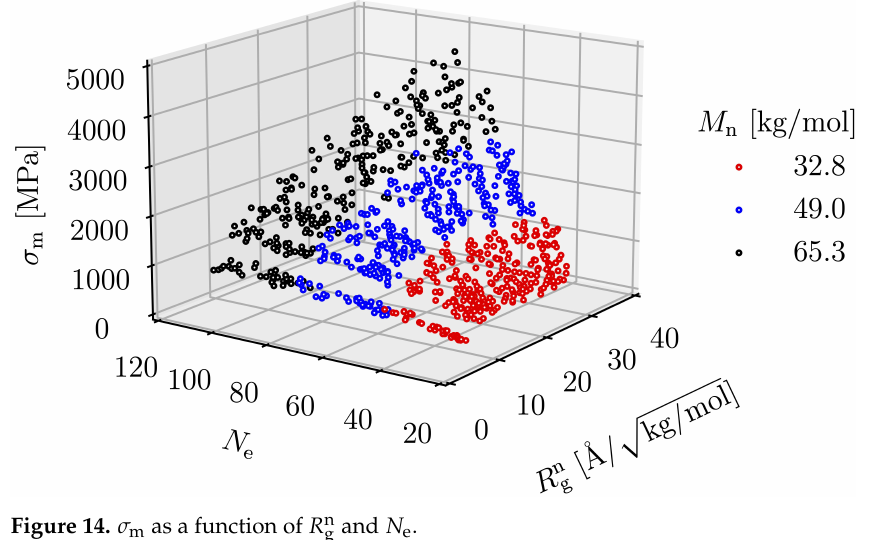
Figure 14. σ m as a function of R n g and N e .